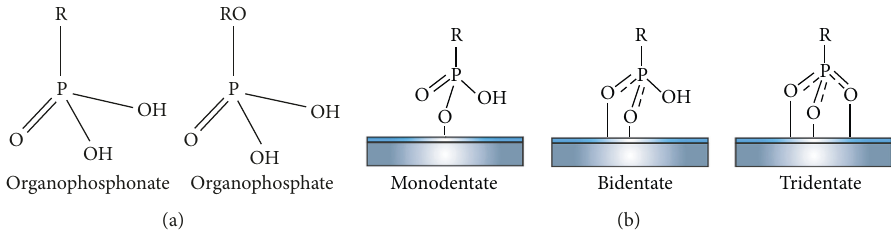
Figure 5: (a) Structure of organophosphate and phosphonate compounds. Adapted from Durmaz [127]. (b) Different bonding modes of a phosphonate unit to a metal oxide surface